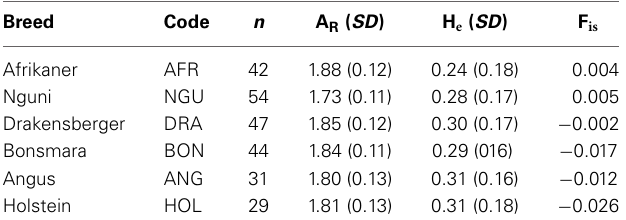
Table 1 | Sample size and genetic diversity within six cattle breeds in South Africa.